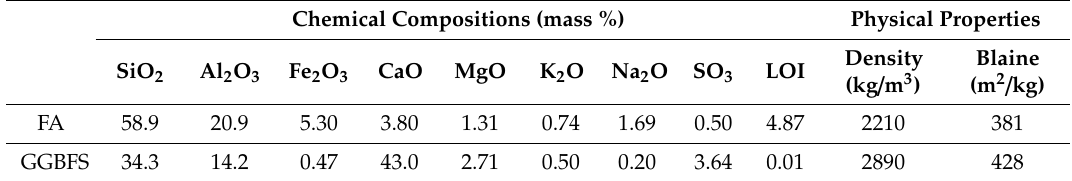
Table 1. Chemical compositions and physical properties of alkali-activated materials (FA and GGBFS). Chemical Compositions (mass